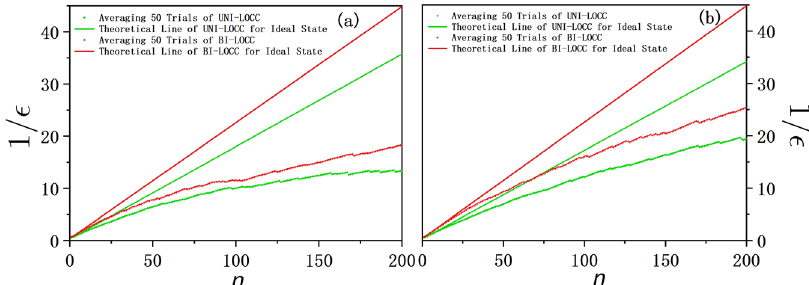
(cid:1) (cid:1) (cid:3) (cid:3) (cid:1) (cid:1) Fig. 4 Experimental QSV of partially entangled states Ψ ð 70 (cid:2) Þ and Ψ ð 80 (cid:2) Þ . Two adaptive strategies, Uni-LOCC and Bi-LOCC, are utilized to study the performance gap between them. In both a and b , δ is set to 0.05, and the value of 1/ ϵ is plotted against the number of measurement n . The averaged results of 50 trials for Ψ ð 70 (cid:8) Þj i and Ψ ð 80 (cid:8) Þj i are shown together with the theoretical lines for ideal states. For both veri fi ed states, a distinct gap in the estimated fi delity can be seen between the Uni- and Bi-LOCC strategies. The standard errors for the averaging data points can be approximately expressed as ε = sn with s = 0.037 and 0.035 for UNI- and BI-LOCC strategies in a , and s = 0.045 and 0.057 for UNI- and BI-LOCC strategies in b averaged results in Fig. 3a in the same range. The ef fi ciency can be characterized by the slope of linear fi tting lines of these data points. For LO, Uni-LOCC and Bi-LOCC strategies, the fi tted slope values of the averaged points are 0.13, 0.17 and 0.187, respectively. After eliminating the effects of the state deviations by considering all-accepted single trials, the fi tted slope values are 0.135, 0.188 and 0.22 for LO, Uni-LOCC and Bi-LOCC strategies, respectively, and these values are exactly the theoretical predic- tions for ideal states. As a result, the ef fi ciency of the Bi-LOCC strategy is 1.63 times higher than that of LO and 1.17 times higher than that of Uni-LOCC. In other words, by introducing bi-